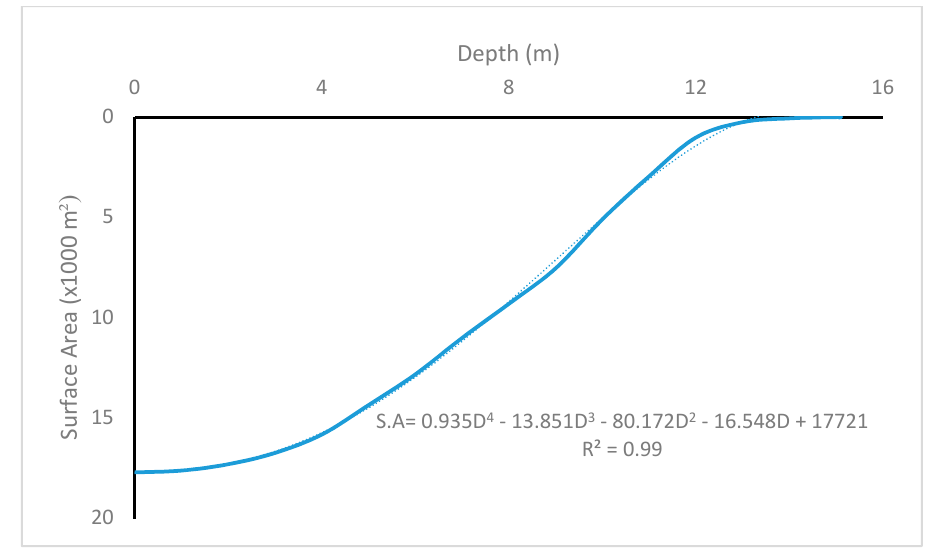
Figure 4. Depth–volume relationship for Rungiri quarry reservoir.